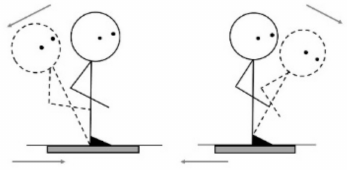
Figure 4. Forward/backward